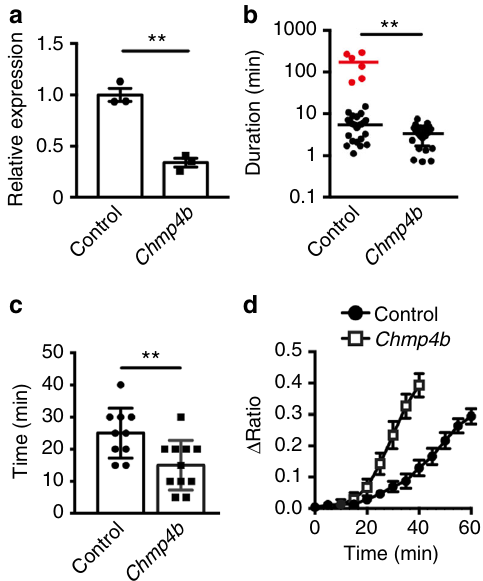
Fig. 10 Knockdown of Chmp4b abrogates a sustained-mode of HMGB1 release. a L929-SMART/HMGB1-mCherry cells were transfected with control or Chmp4b siRNA, and knockdown ef fi ciency was determined by qPCR at 24 h after transfection. Results are means± s.d. of triplicate samples and representative of two independent experiments.